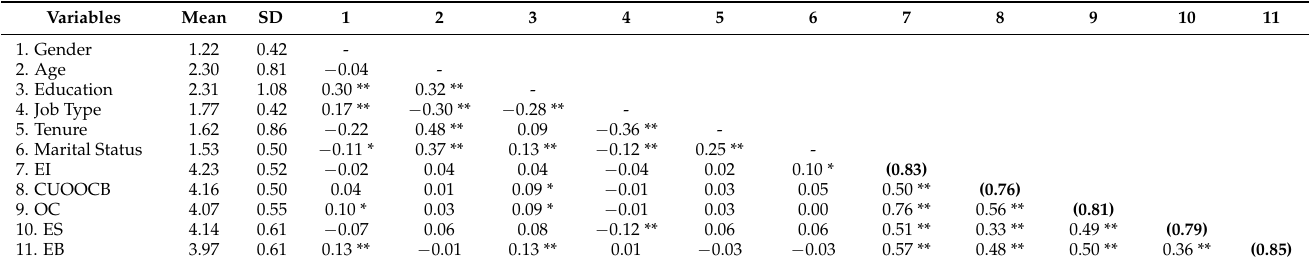
Table 3. Means, standard deviations, and correlations of the study